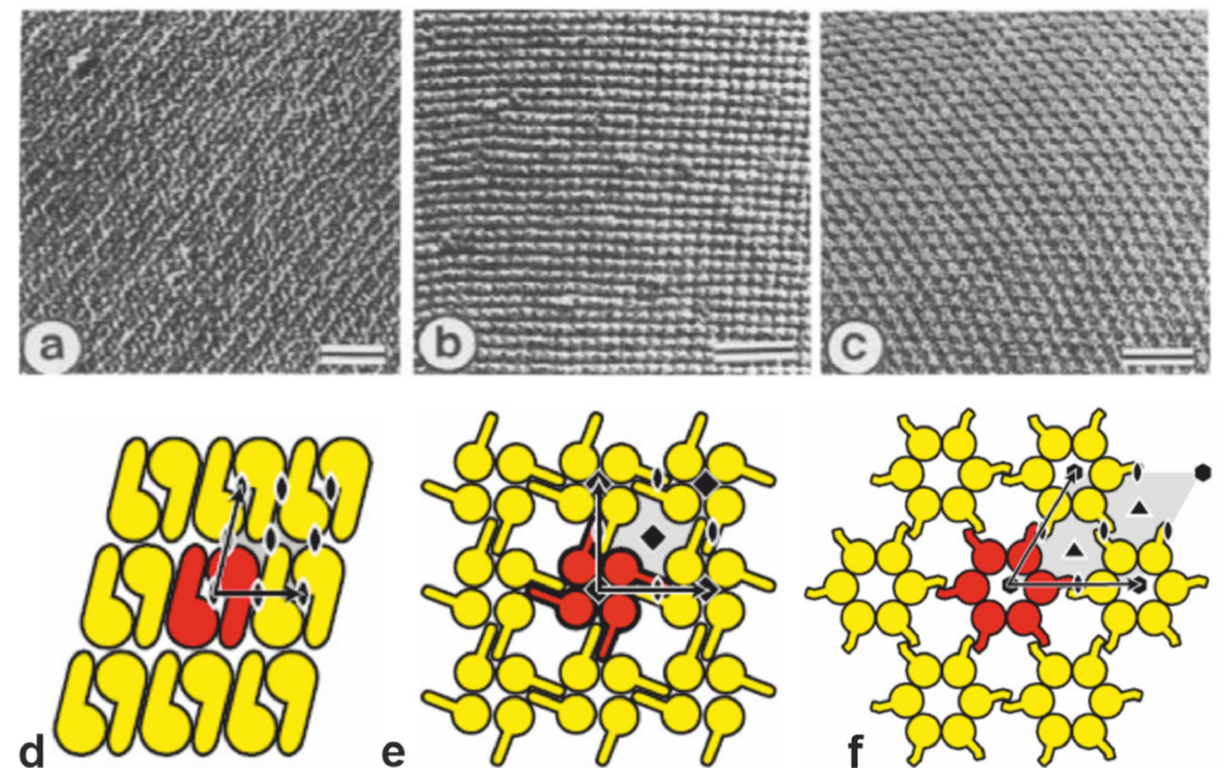
Figure 1. ( a – c ) Transmission electron micrographs of freeze-etched preparations of S-layer on intact cells showing three lattice types schematically determined in ( d – f ). ( a , d ) oblique (p2) lattice; ( b , e ) square (p4) lattice; ( c , f ) hexagonal (p6) lattice. The bars in a-c represent 50 nm. In d-f, the different S-layer lattice types, their base vectors, the unit cell (shaded in gray), and the corresponding symmetry axis are depicted. The proteins at one morphological unit are shown in red. ( a – c : Adapted from [11]. Copyright © 1988 with permission from Elsevier Science Publishers B.V. Amsterdam, The Netherlands. d – f : With permission from Ref. [6] (CC BY-NC-ND